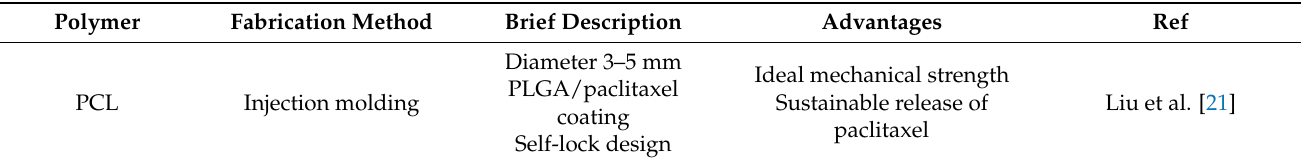
Table 2. Summary of injection molding, weaving, laser cutting, and 3D